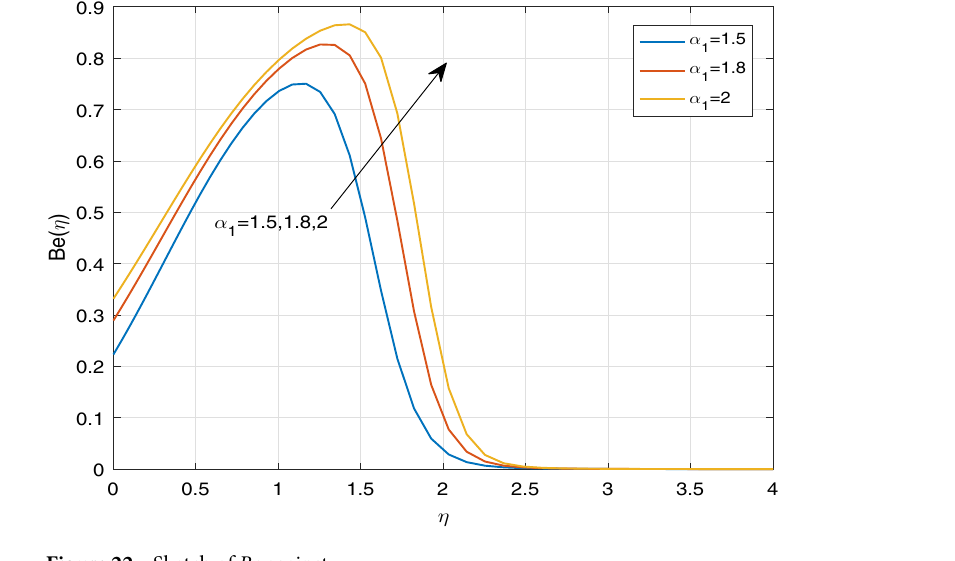
Figure 22. Sketch of Be against α 1